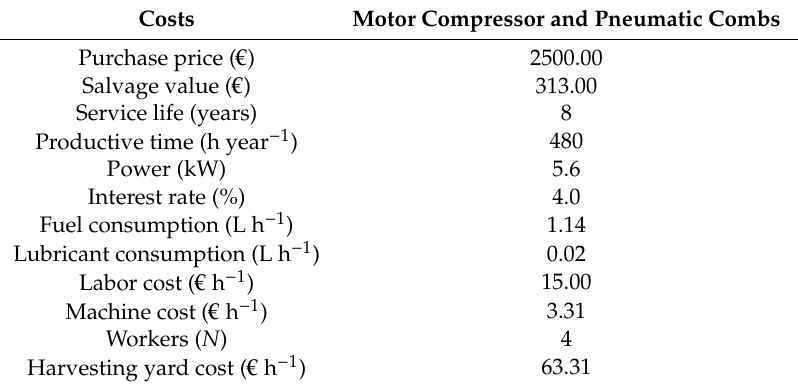
Table 2. Main elements considered in the cost calculation and hourly cost of the olive harvesting